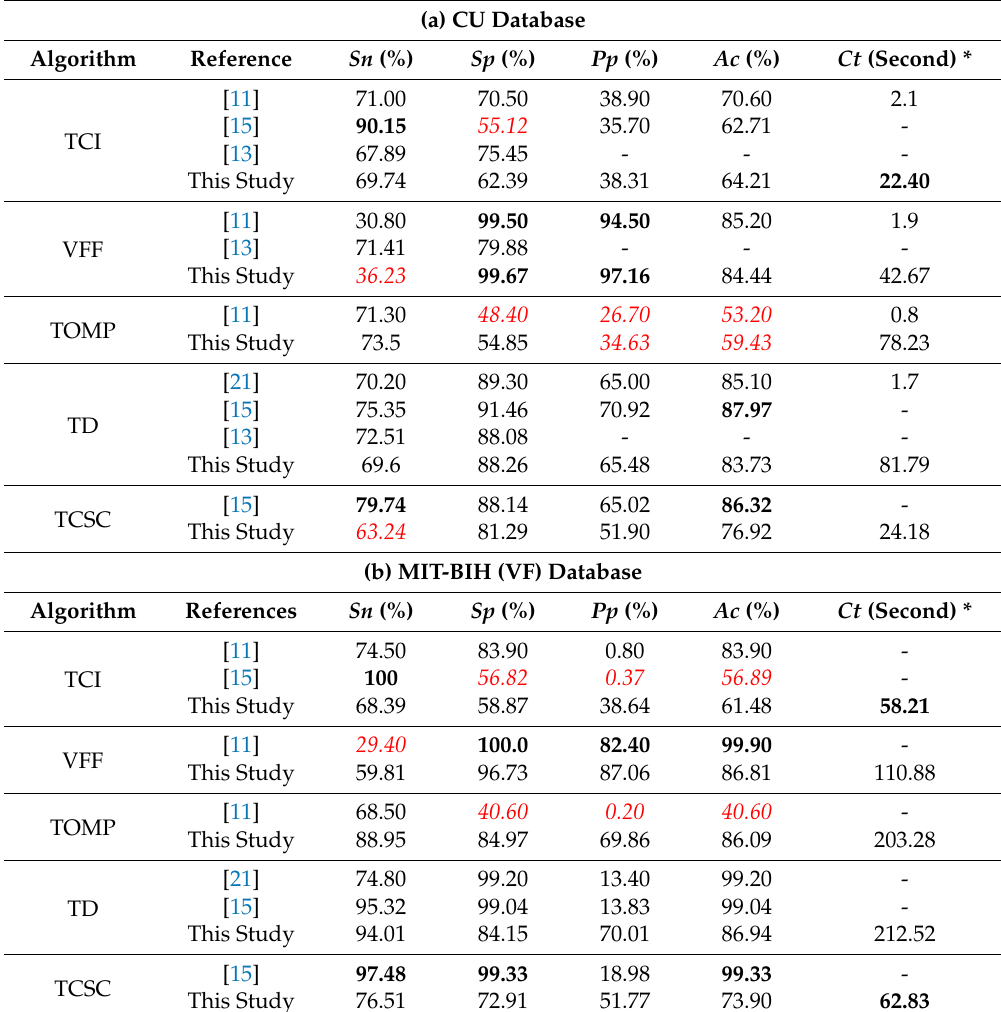
Table 3. Summary of performance for VF detection